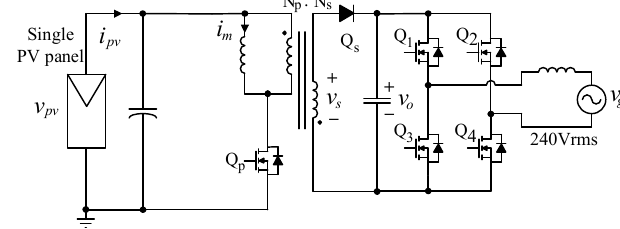
Figure 1. Flyback inverter in PV AC module application.